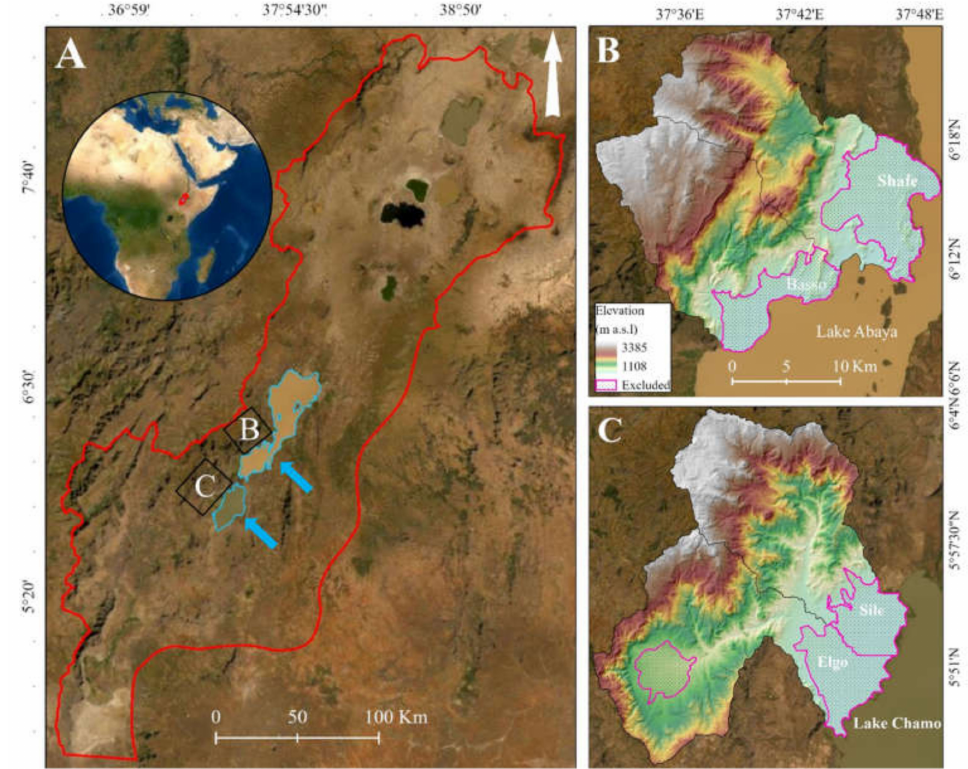
Figure 1. Location of the study area. ( A ) Lakes Abaya and Chamo within the Main Ethiopian Rift (blue arrows). The contrasting sediment patterns between the two lakes can also be visualized. The red line delineates the lakes’ basin. ( B ) Shafe and Basso, draining to Lake Abaya, and ( C ) Sile and Elgo, draining to Lake Chamo. Pink polygons with the dots represent the flatter areas excluded from the analysis. Background imagery is from Google Earth (15 June